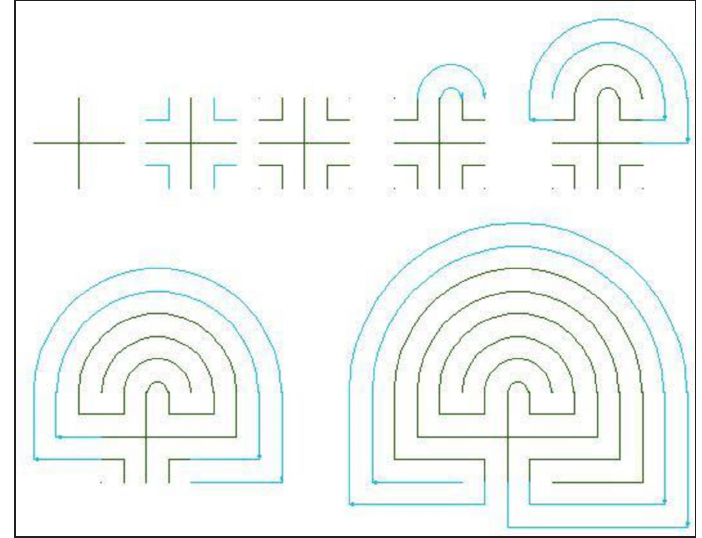
Figure 6: Seed and Cretan labyrinth. Photo: Nm5mini. “How to do